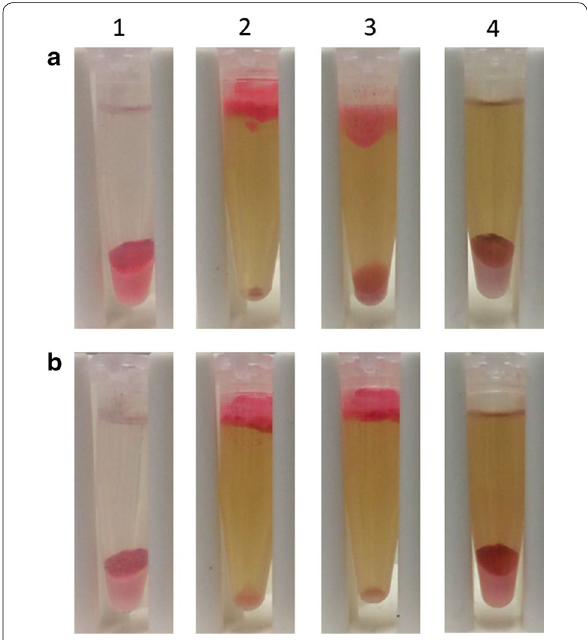
Fig. 4 Pretreatment optimization analysis. The pretreatment optimization analysis was achieved by a using different concentrations of NaOH incubated for a 4 h with tailor-made enzymes (TMEs) and b 24 h with TMEs. Column (1) Control sample incubated with demi water, column (2) 1 M NaOH, column (3) 0.5 M NaOH column (4) 0.1 M NaOH. All assays were performed using a 24 h incubation time of NaOH pretreatment and a final TME concentration of 187 mg L − 1